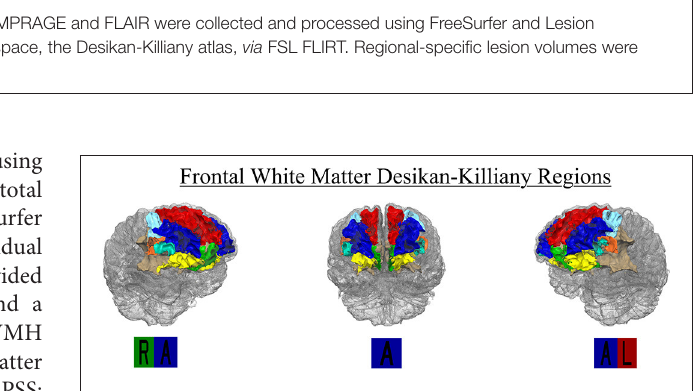
FIGURE 2 | Region-specific WMH Desikan-Killiany ROIs included in final analysis ( n = 16). Regions included right and left hemisphere Superior Frontal (red), Rostral (blue), and Caudal (light blue) Middle Frontal, Medial (green) and Lateral Orbitofrontal (yellow), Pars Opercularis (orange), Pars Triangularis (cyan), and Periventricular/Deep Frontal